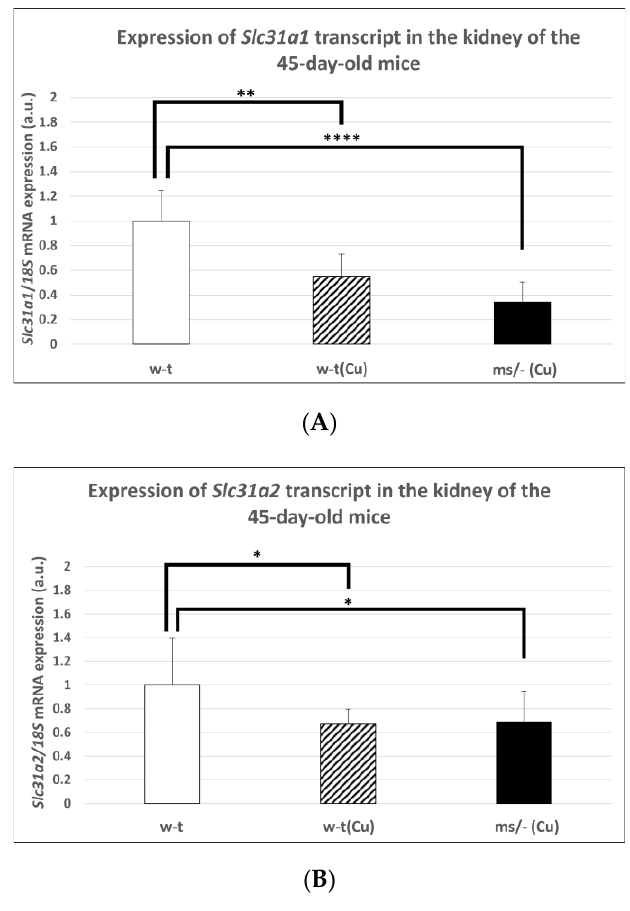
Figure 4. Decreased expression of the Slc31a1 ( A ) and Slc3a2 ( B ) genes in the kidney of 45-day-old copper-treated w-t and mosaic mutant mice. The histograms display mRNA levels in arbitrary units (means ± S.D., n = 5, (* p < 0.05, ** p < 0.01, **** p <